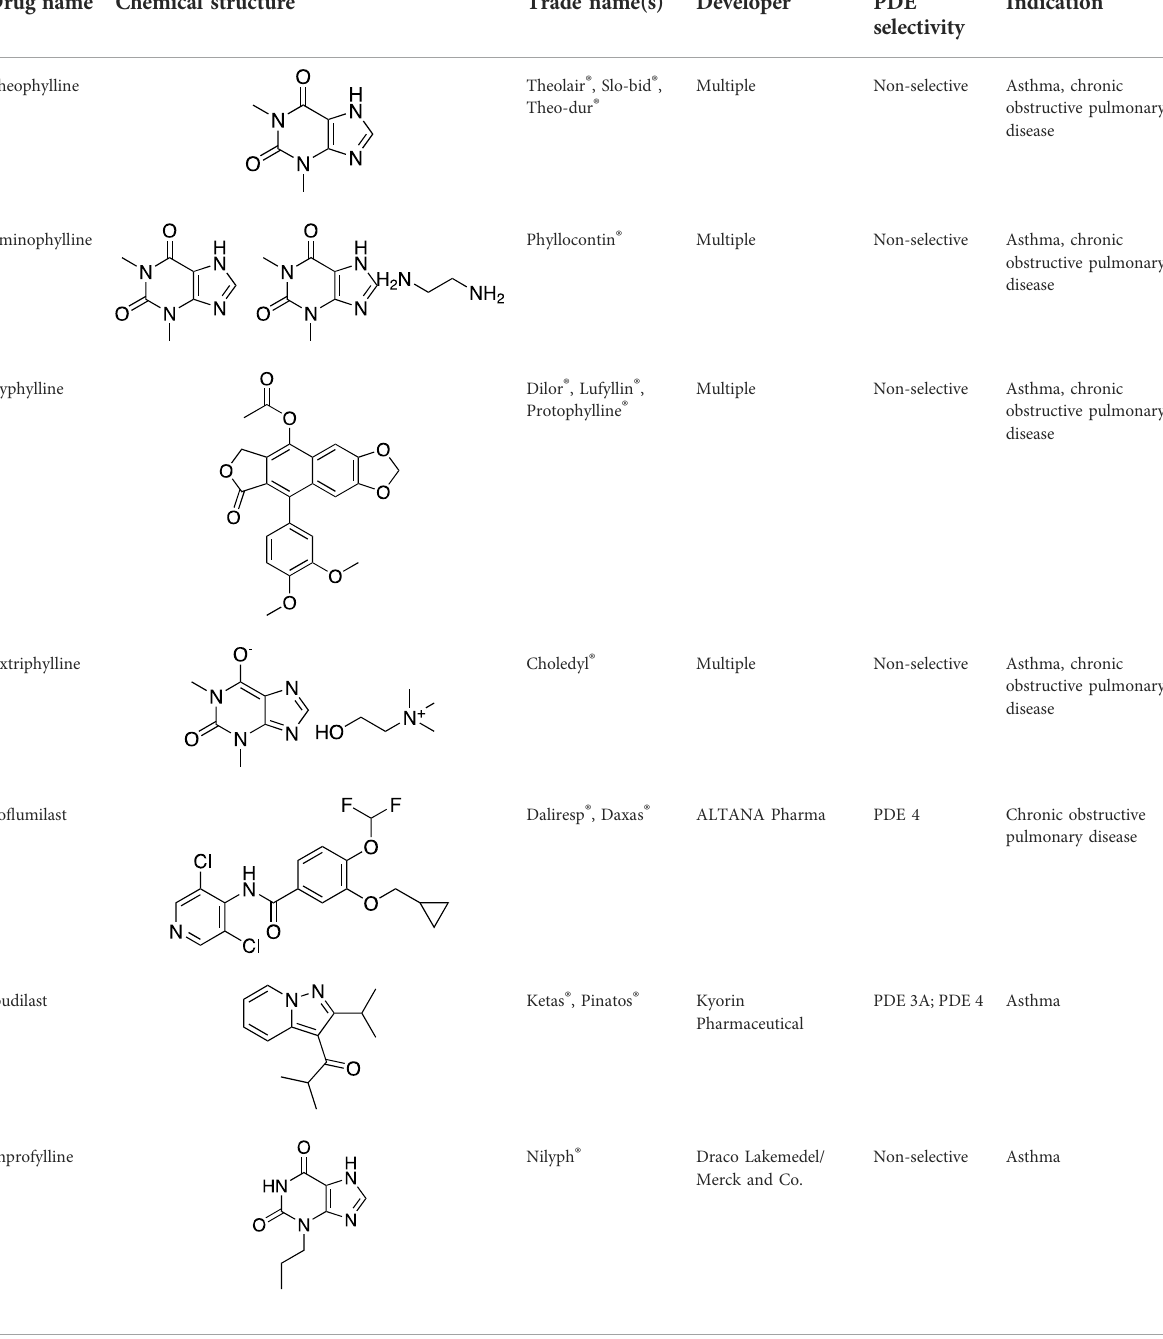
TABLE2MarketedPDEinhibitors inpulmonarydiseases.Thistableprovides asummaryontheavailableclinicalevidenceformarketedPDEinhibitors in lung diseases. Trade names, developer name and the targeted PDE isozymes are listed according to the PubChem, DrugBank and Drugs@FDA database records. Chemical structures are derived from the PubChem database (Kim et al.,